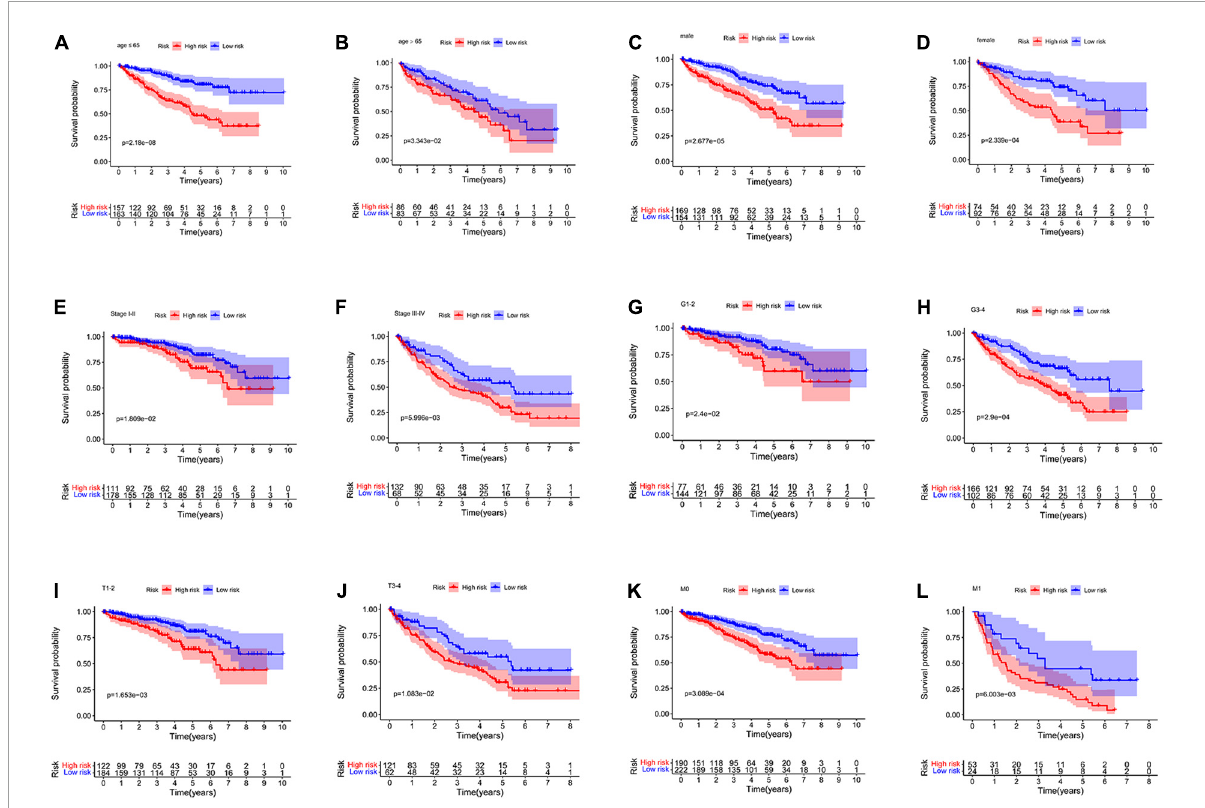
FIGURE6 Kaplan–Meier curves for the high- and low-risk groups in different subgroups. (A) age ≤ 65 years; (B) age > 65 years; (C) men; (D) women; (E) stage I–II; (F) stage III–IV; (G) grade 1–2; (H) grade 3–4; (I) T 1–2; (J) T 3–4; (K) M0; (L) M1. M, metastasis; T, tumor